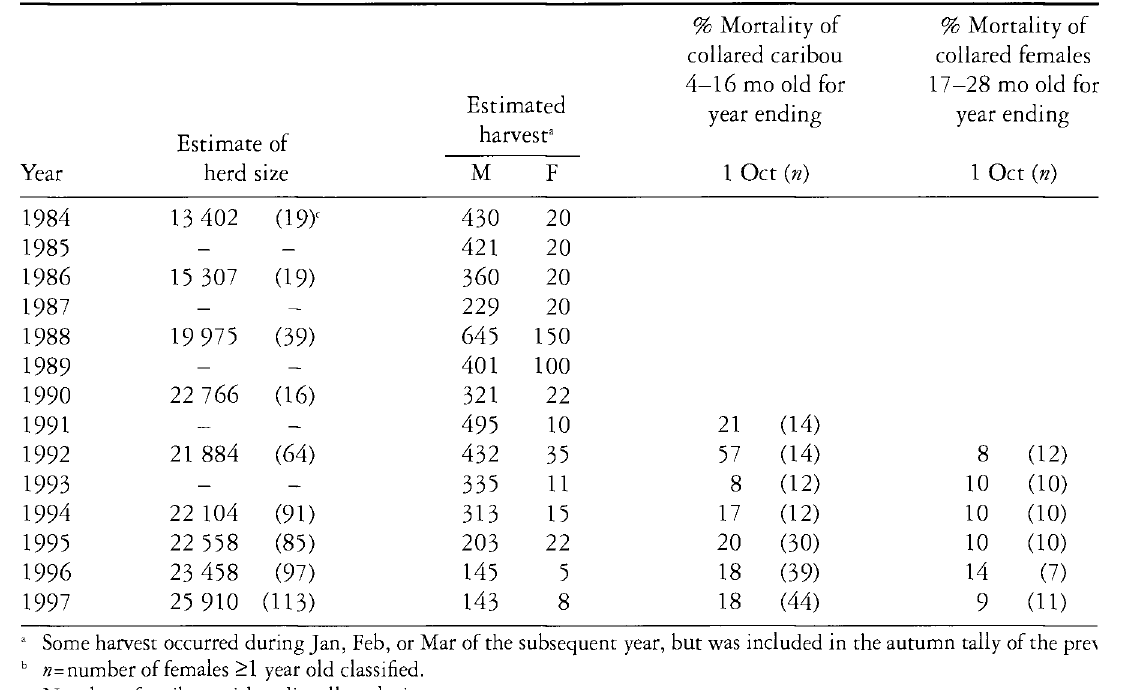
Estimate of herd